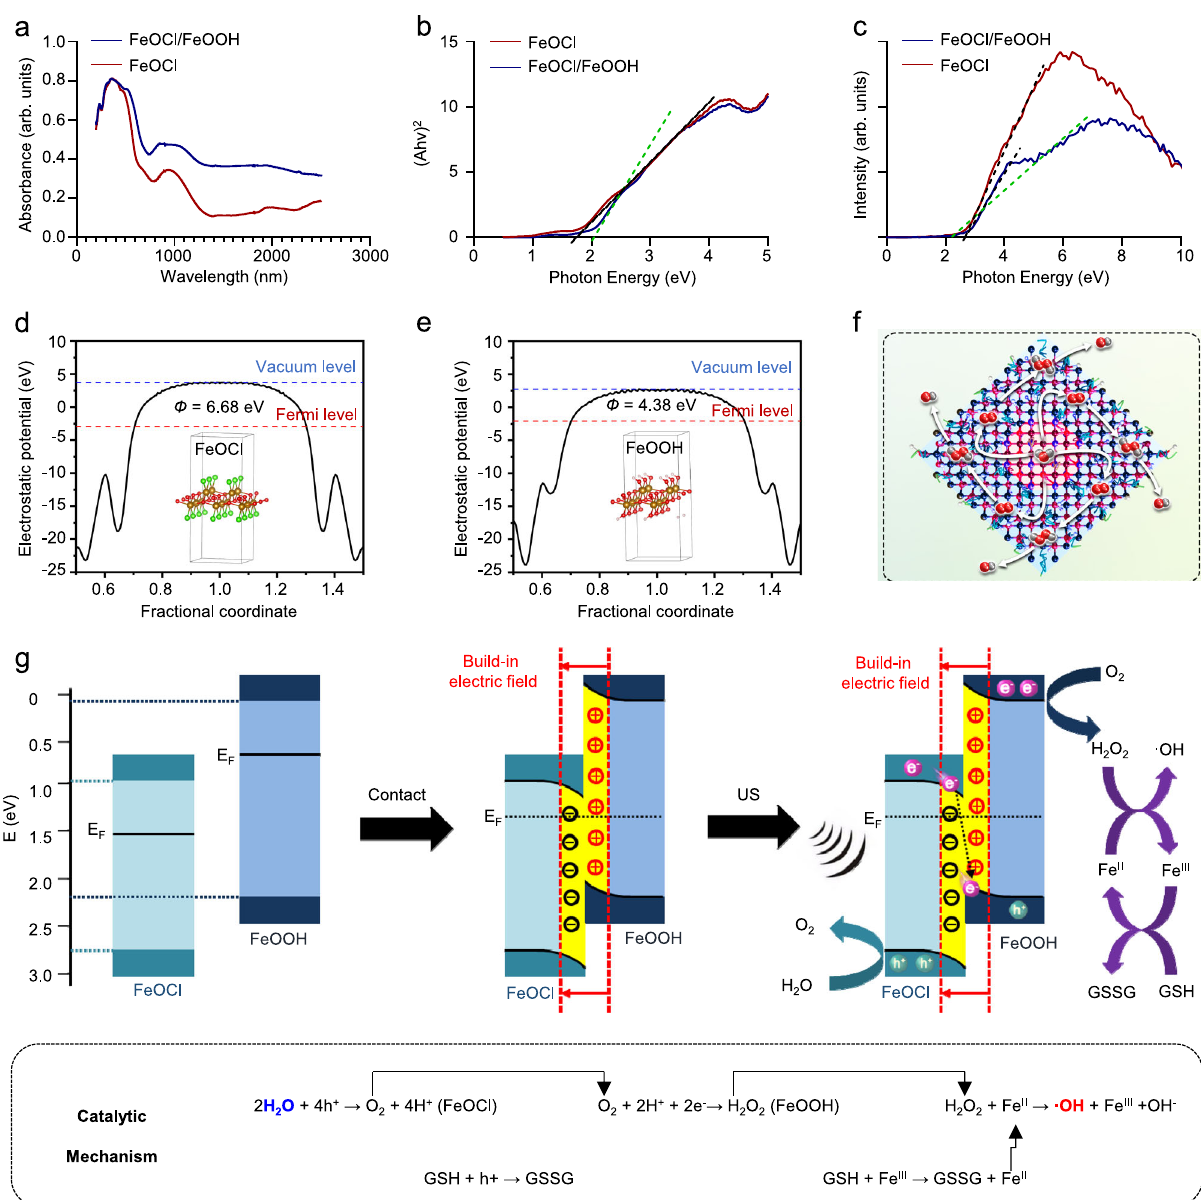
Fig. 5 Catalytic mechanism analysis of FeOCl NSs and FeOCl/FeOOH NSs. a UV – Vis absorbance spectra and b calculated band gap of FeOCl NSs and FeOCl/FeOOH NSs. c Valence band of FeOCl NSs and FeOCl/FeOOH NSs calculated from XPS spectra. Density functional theory (DFT) computational calculations of d FeOCl and e FeOOH. f Schematic illustration and chemical reaction equations of Z-schemed heterojunction based on FeOCl/FeOOH NSs for ·OH generation using water as the only substrate. g Mechanism of Z-schemed heterojunction based on FeOCl/FeOOH NSs for ·OH generation. For these characterizations of fabricated FeOCl NSs and FeOCl/FeOOH NSs, including UV – Vis absorbance spectra, band gap, valence band, and DFT computational calculations, three times each experiment was repeated independently with similar results. The units (arb. units) of UV – Vis absorbance spectra and XPS spectra mean arbitrary units. Source data are provided as a Source Data fi